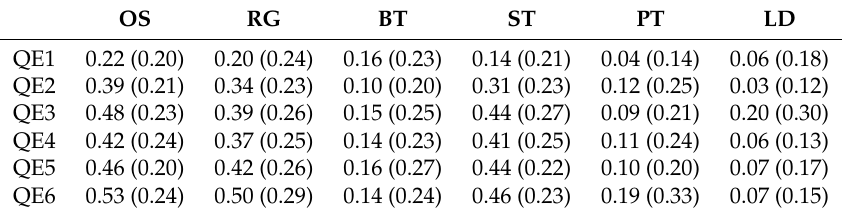
Table 5. CAPEV mean and deviation values in terms of VLT session. The display format was x ( y ) , where x was the mean and y was the standard deviation. OS: overall severity, RG: Roughness, BT: Breathiness, ST: Strain, PT: Pitch, LD: